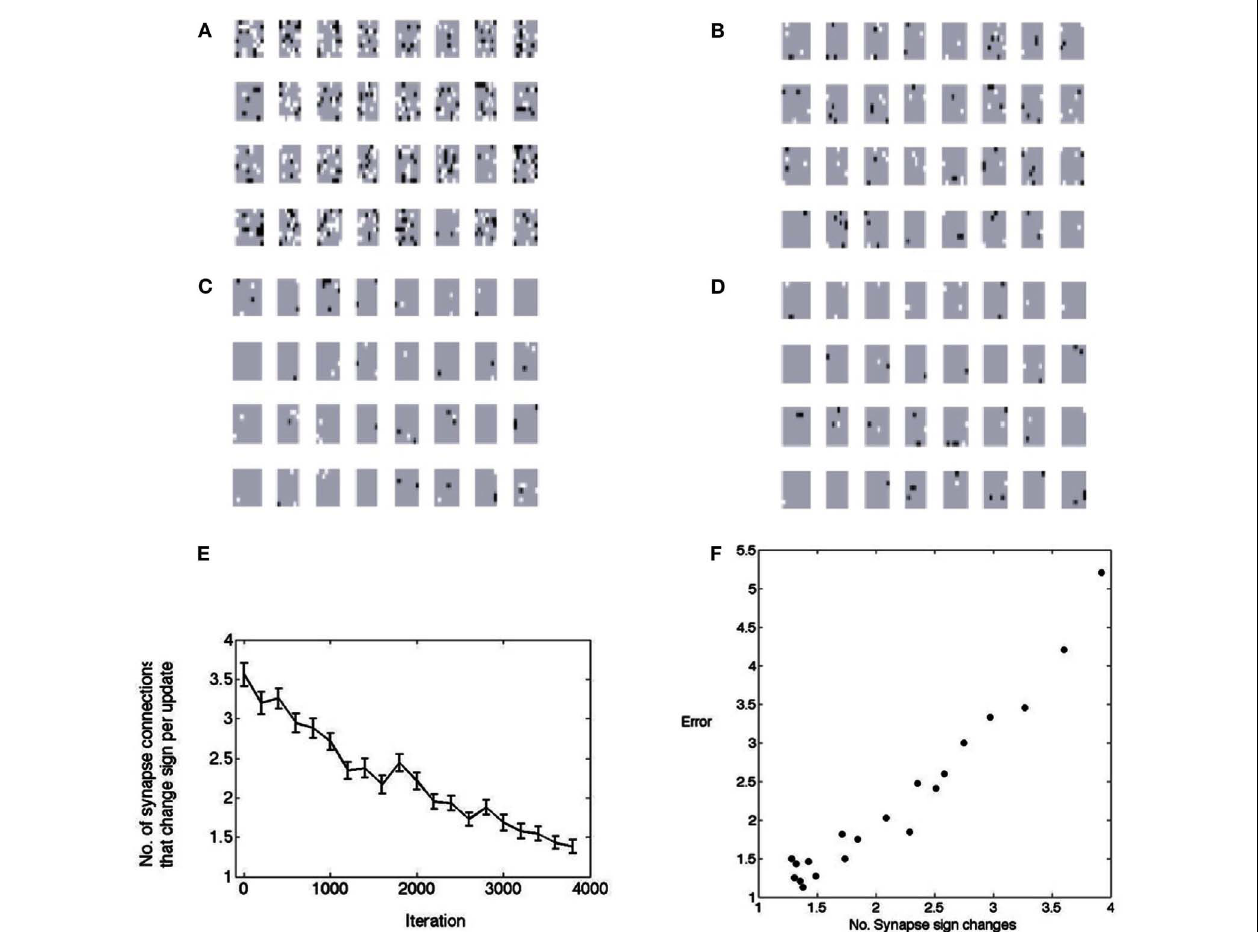
256. Fifty samples are used in computing the standard error bars.Thus initially, on every learning update, about 5% of the synapses need to change signs. At the end of learning this number is down to less than 0.5%. (F) The change in synapse polarity is tightly correlated with the residual error in fitting receptive fields ( r = 0.97), suggesting that the changes in polarity can be used to track the progress of receptive field